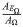
The rates of AEΩAΩ (blue points) and AEΦAΦ (red points) for Eq (7) on the open dataset.Note that Eq (7) is reasonable since the red points approach to the blue points. The average rate of the 237 images is 0.132 for the blue points and 0.097 for the red points. The mask is randomly with 425 unknown region.